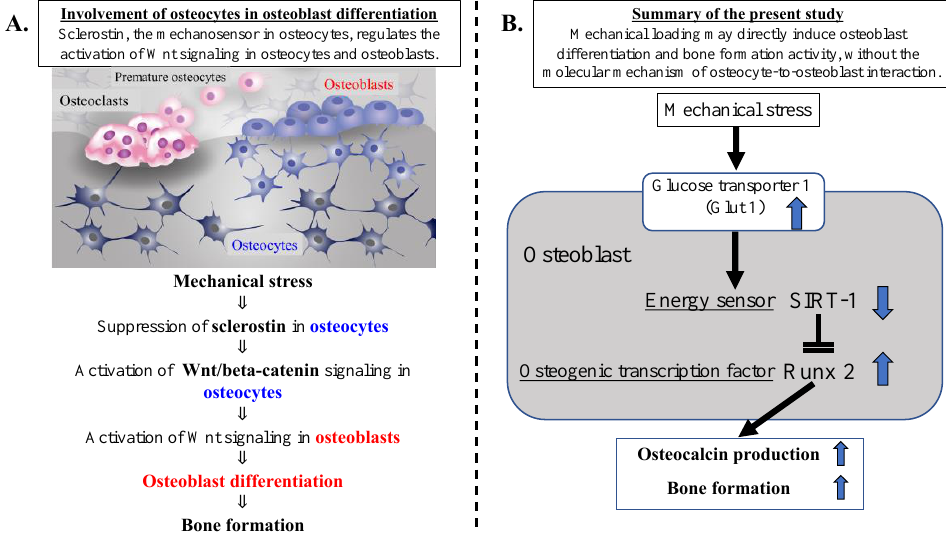
Figure 8. Summary of our current study. ( A ) Involvement of osteocytes in osteoblast differentiation. Mechanical loading suppresses the expression of osteocytic sclerostin following activation of Wnt/beta-catenin signaling in osteocytes and osteoblasts, resulting in osteoblast differentiation and bone formation activity. Cellular interaction of osteoblasts with osteocytes, via the sclerostin – Wnt/beta-catenin signaling pathways, plays an important part in physiologic mechanical stress-mediated bone metabolism. ( B ) Mechanical loading may directly induce osteoblast differentiation and bone formation activity, without the molecular mechanism of osteocyte-to-osteoblast interaction. The mechanical stress-induced expression of Glut1 and resultant uptake of glucose may suppress the level of the energy sensor SIRT1 in osteoblast energy metabolism. Since SIRT1 is recognized to negatively regulate Runx2 activity, the mechanical stress-induced suppression of SIRT1 results in increased activity of the osteogenic transduction factor Runx2 in osteoblasts, leading to osteoblast differentiation and bone formation.